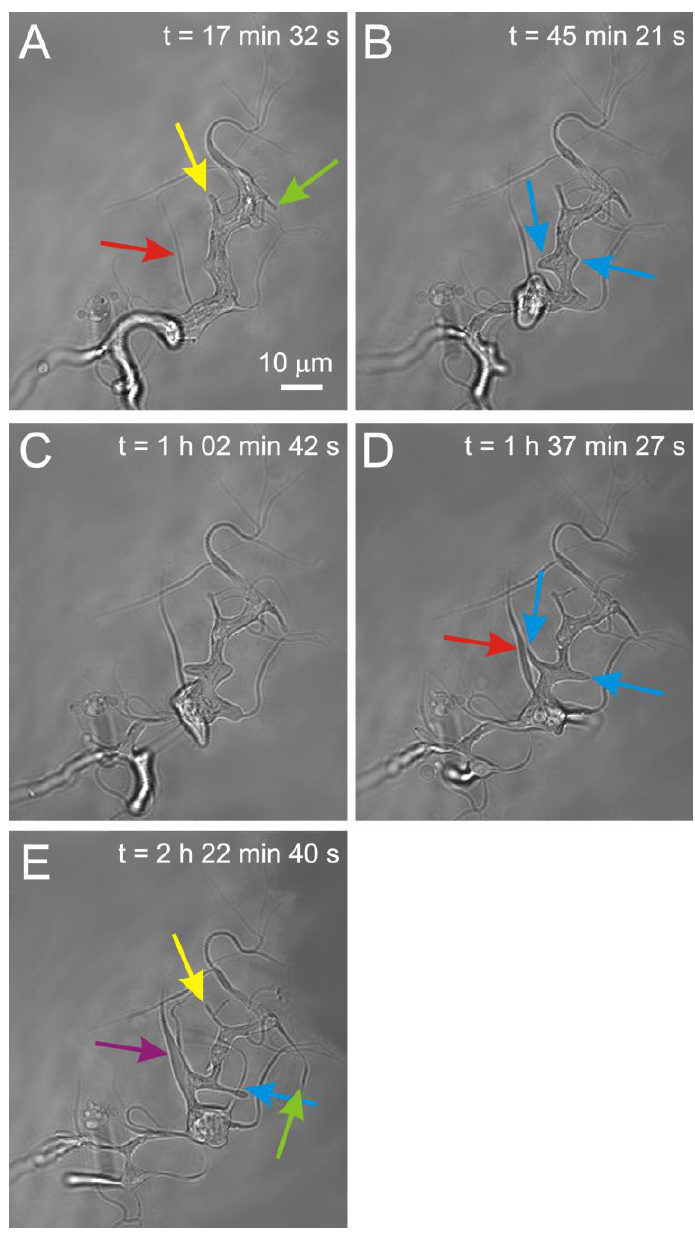
FIGURE 2. A series of transmitted light images of an arterial IC undergoing shape change. The cell was adhering to a laminin-coated coverslip and was placed in a physiological salt solution. Several different phenomena can be observed: elongation (green arrows), thinning (yellow arrows) or thickening of filopodia (red arrows), development of protuberations (blue arrows), and fusion of a protuberation with the thickened filopodium (purple